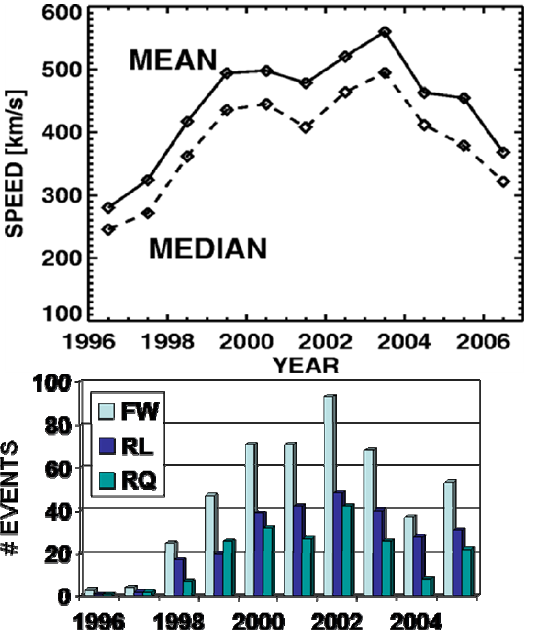
27Figure 1. Annual numbers of FW CMEs and the RQ and RL subsets for the years 1996 to Fig. 1. Annual numbers of FW CMEs and the RQ and RL subsets 2005 (bottom). The annual variation of the mean CME speed (top) is also shown for for the years 1996 to 2005 (bottom). The annual variation of the comparison. mean CME speed (top) is also shown for comparison.